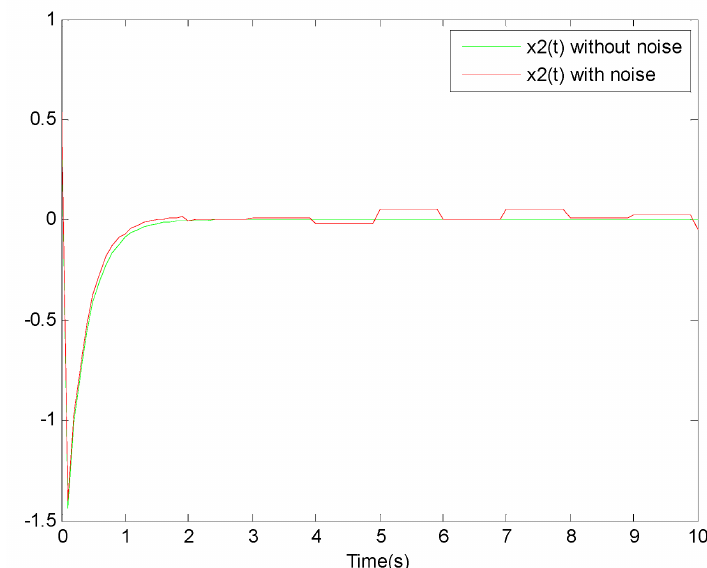
Figure 18. The state evolution x 2 ( t ) with σ = 0.03.